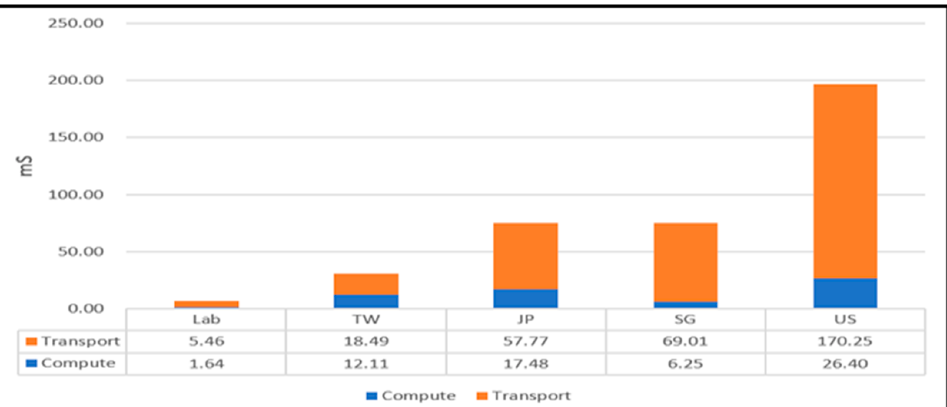
Figure 17. Cost of querying IRI for the information of known